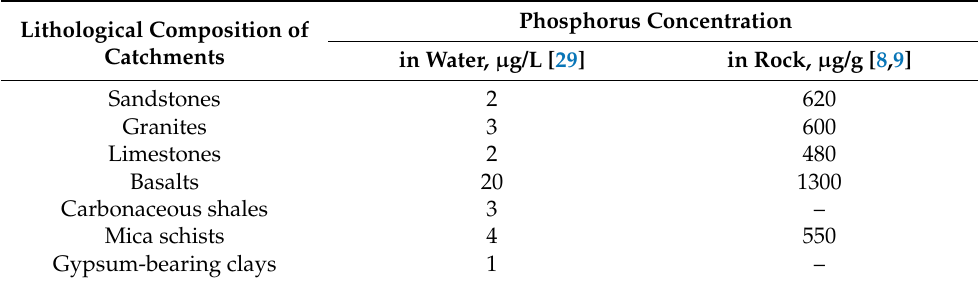
Table 8. Relationship between the concentration of dissolved mineral phosphorus in the waters of the primary hydrographic network and phosphorus content in the catchment